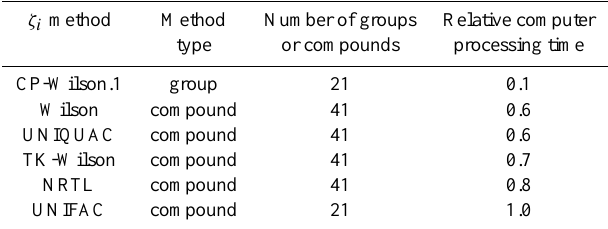
Table 5. Comparison of relative computer processing time required for six ζ i prediction